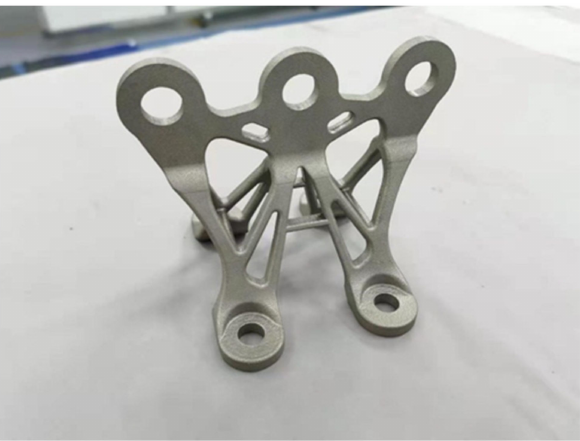
Figure 14. New bracket after 3D-printing with EOS